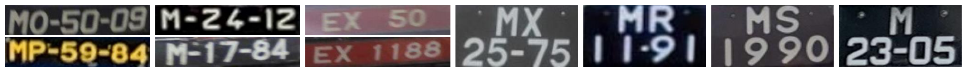
Figure 1. Some examples of variable-length license plates. Different numbers, colors, and fonts are